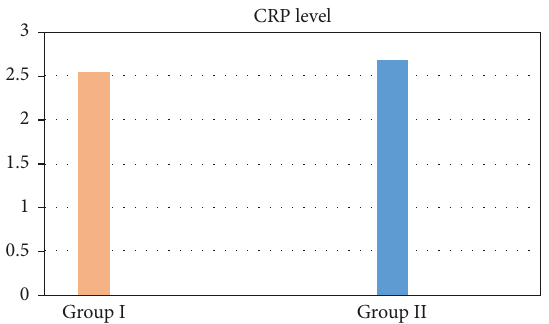
Figure 1: Average C-reactive protein values, obtained in both groups, presented